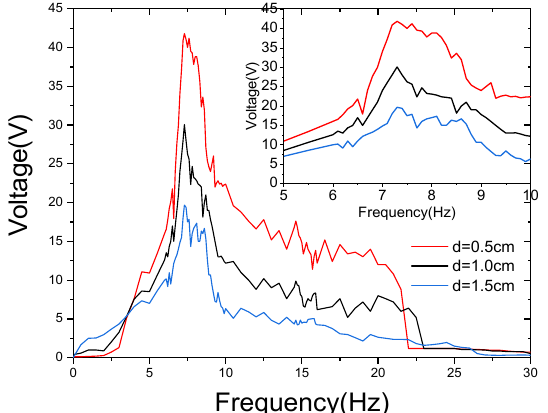
Figure 9. The measured open-circuit voltages against operating frequencies, ranging from 0 to 30 Hz, under various impact gaps.